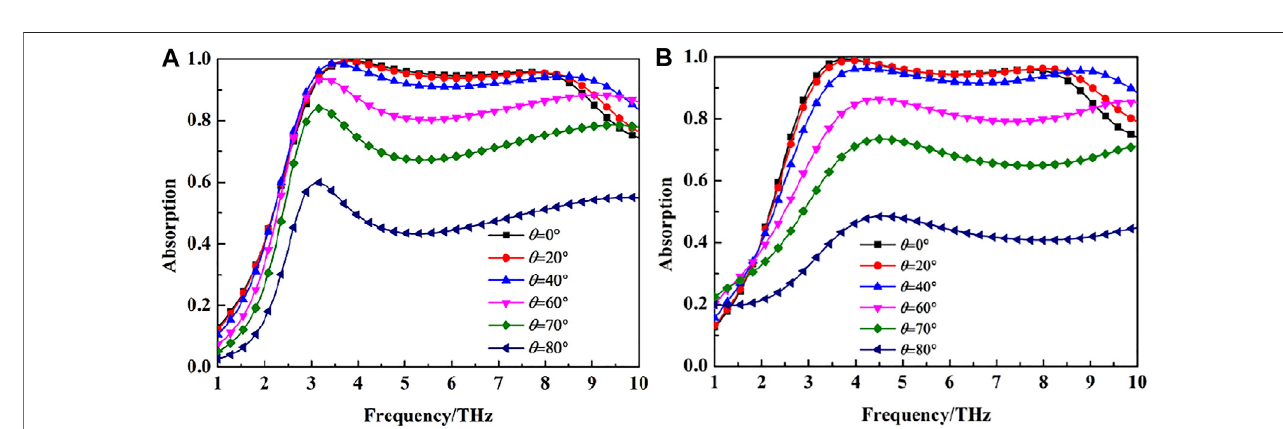
FIGURE 7 | The absorption of the metamaterial absorber at different incident angles ( T (cid:1) 300 K), (A) TE mode, (B) TM mode.